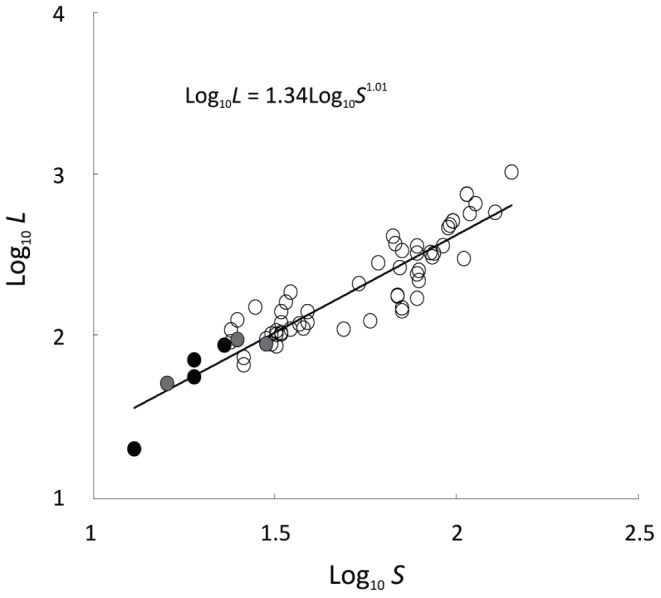
Relationship between taxon richness (S) and number of links (L).Ödenwinkelkees food webs are shown in black and reported literature values as open circles. Grey symbols highlight the alpine stream food webs collected by Lavandier & Décamps [31].